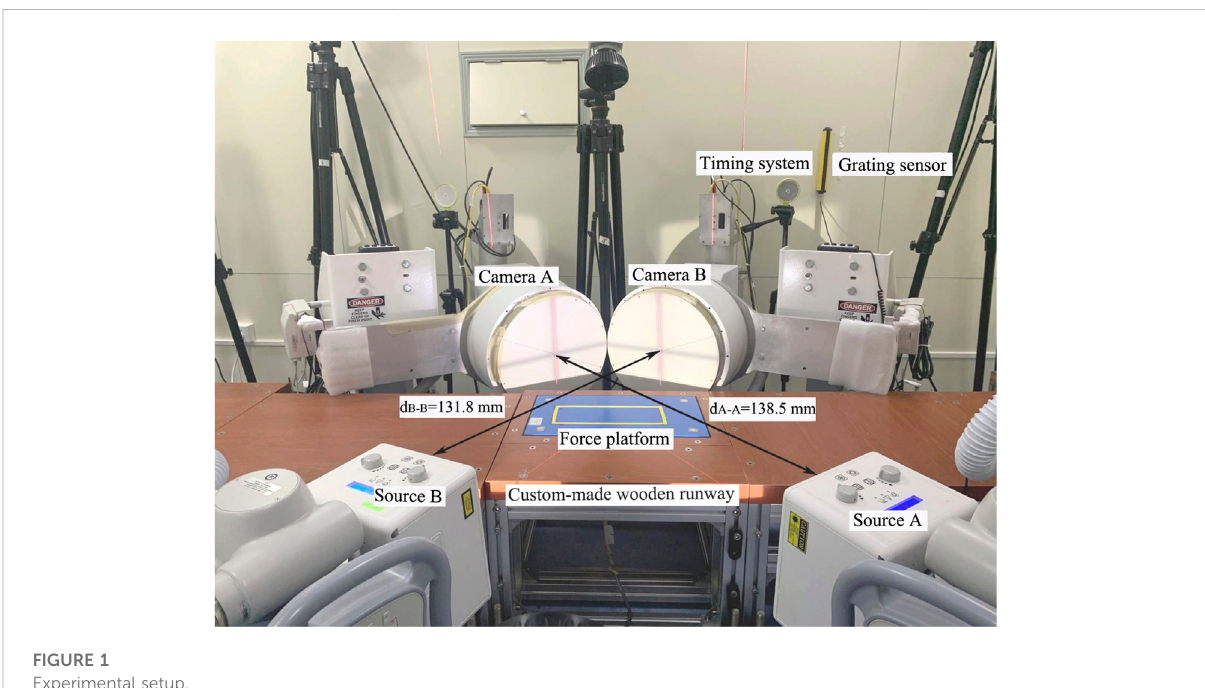
FIGURE 1 Experimental